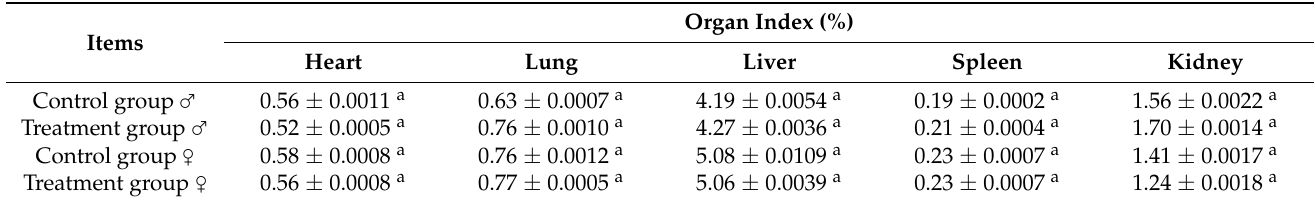
Table 10. Effects of B1302 culture filtrate on organ index of mice in each group.